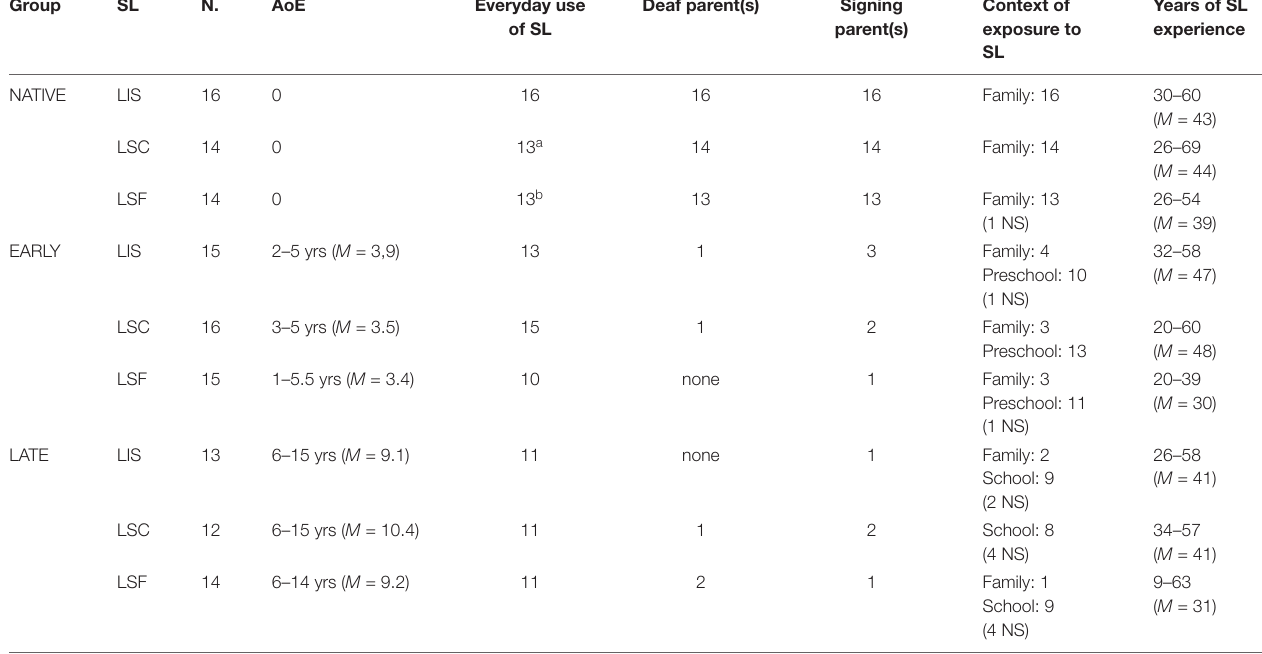
TABLE 2 | Summary of SIGN-HUB participants’ characteristics per group and